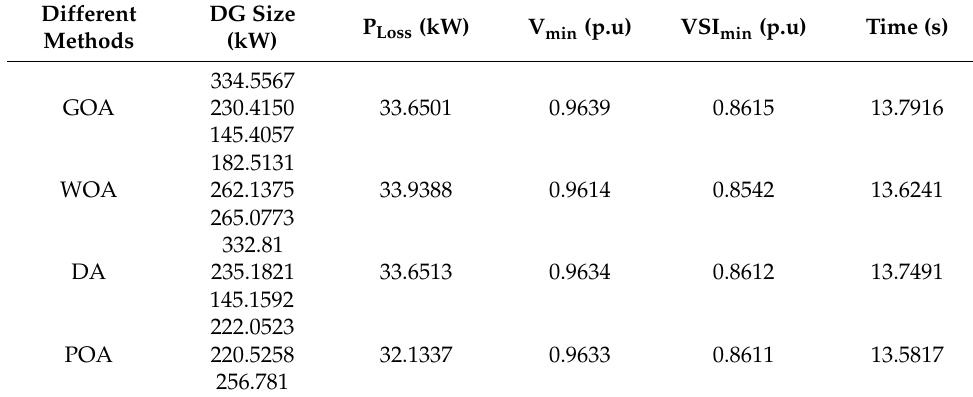
Table 4. POA method results compared with other optimisation methods.